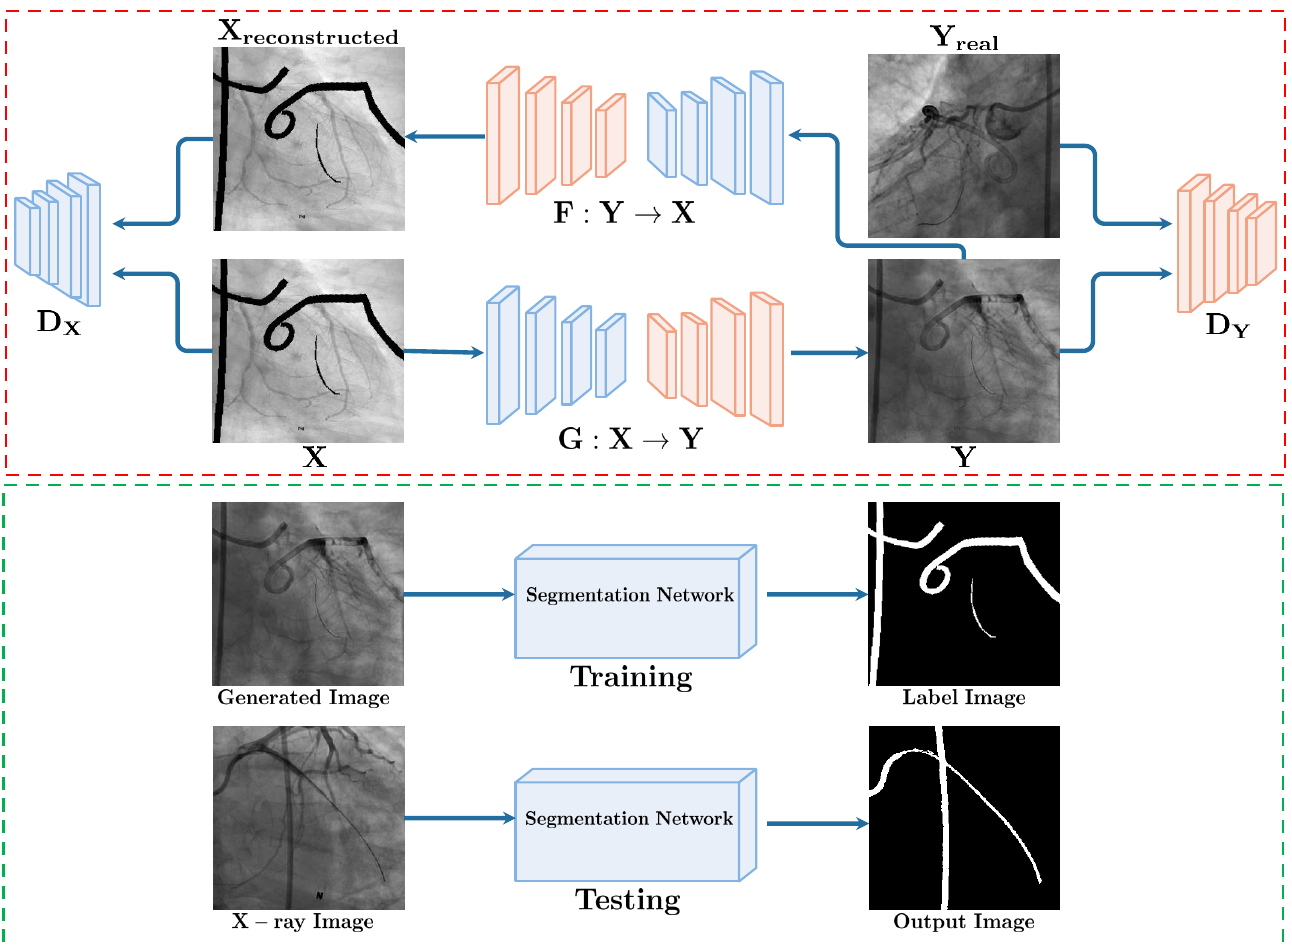
Figure 1. Overall framework of the proposed synthesis and segmentation of catheters in X-ray. The catheter sythesis is represented with red dotted line, while the catheter segmentation is represented with a sgreen dotted